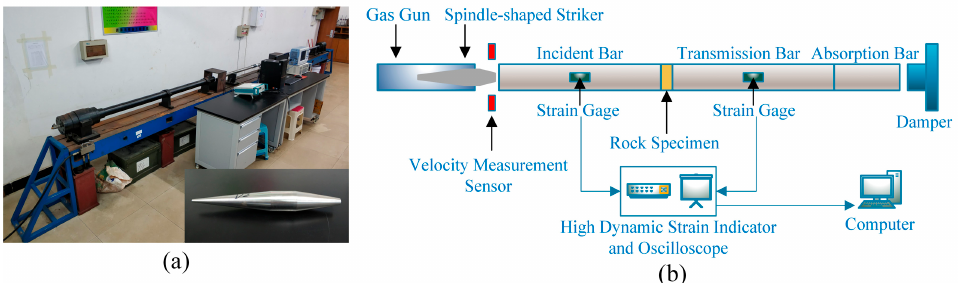
Figure 8. Split Hopkinson pressure bar test system: ( a ) SHPB device, Central South University; ( b ) schematic diagram.